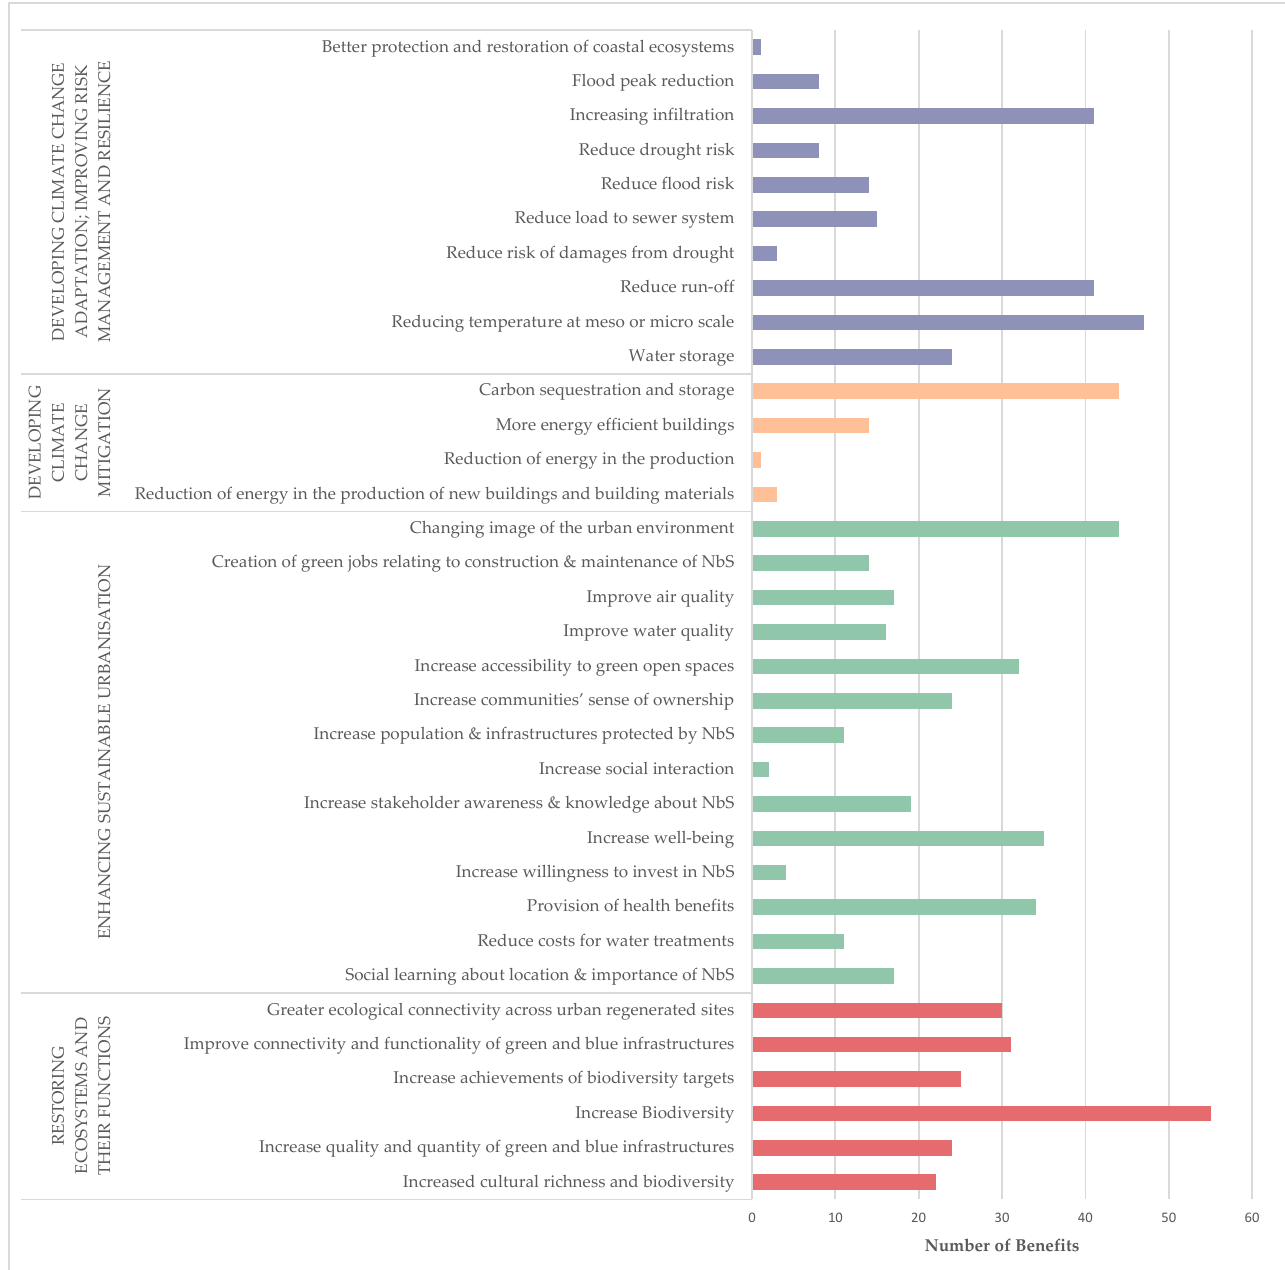
Figure 8. Multiple benefits NbS.